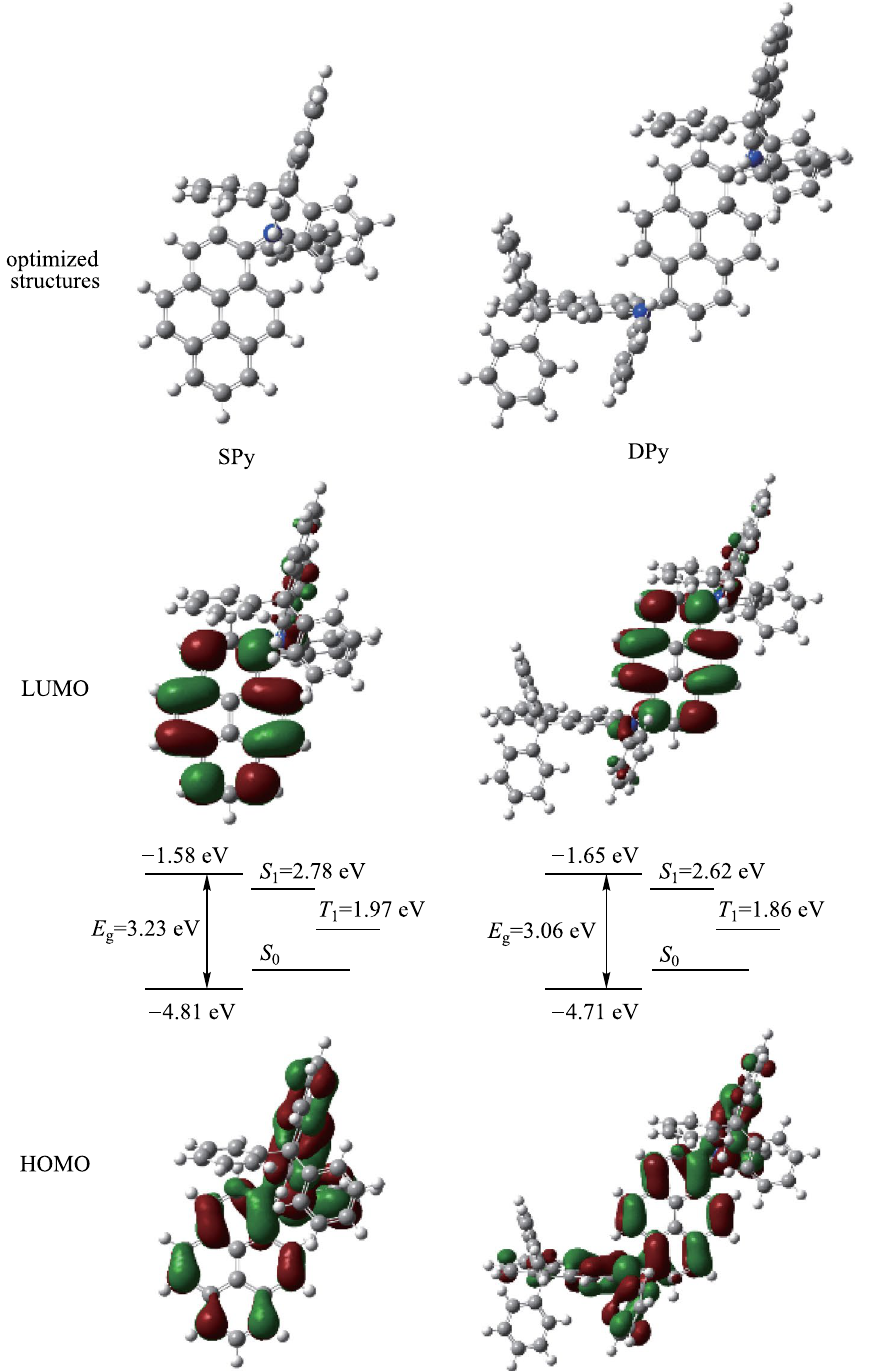
Fig. 1 Optimized geometric structures and HOMO/LUMO analysis of SPy and DPy (the excited state energy levels S